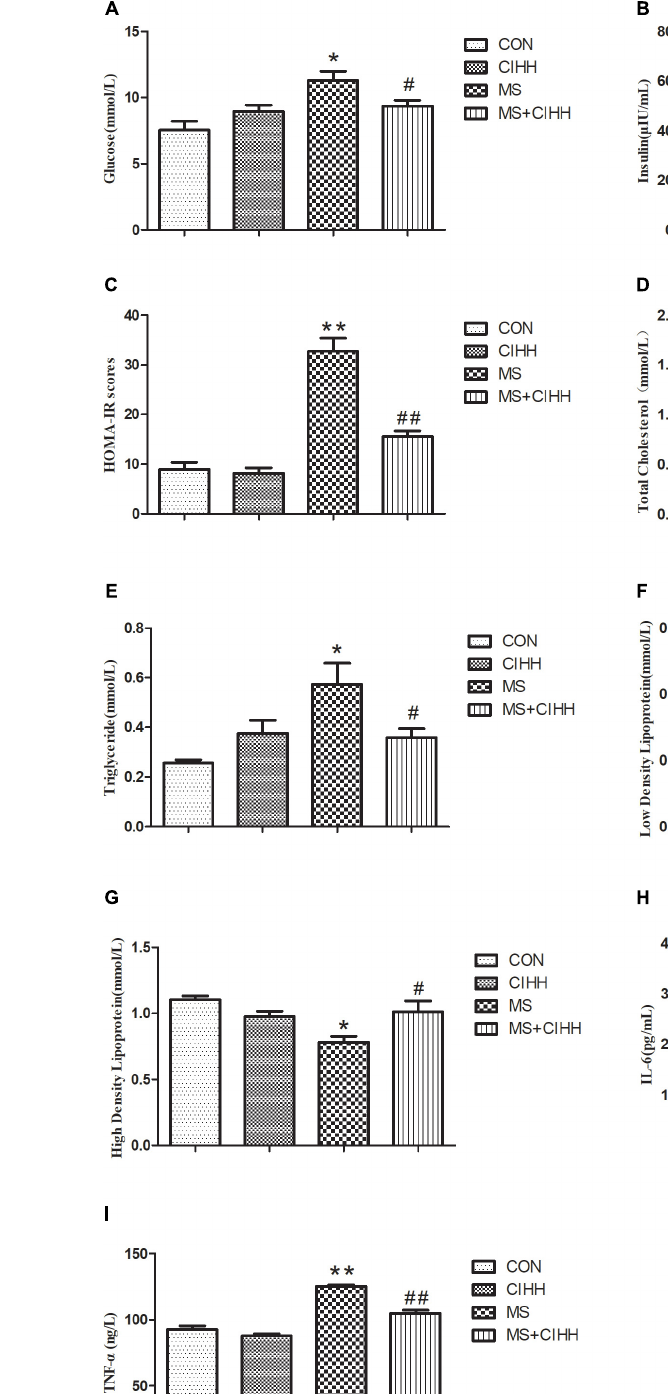
Frontiers in Physiology |